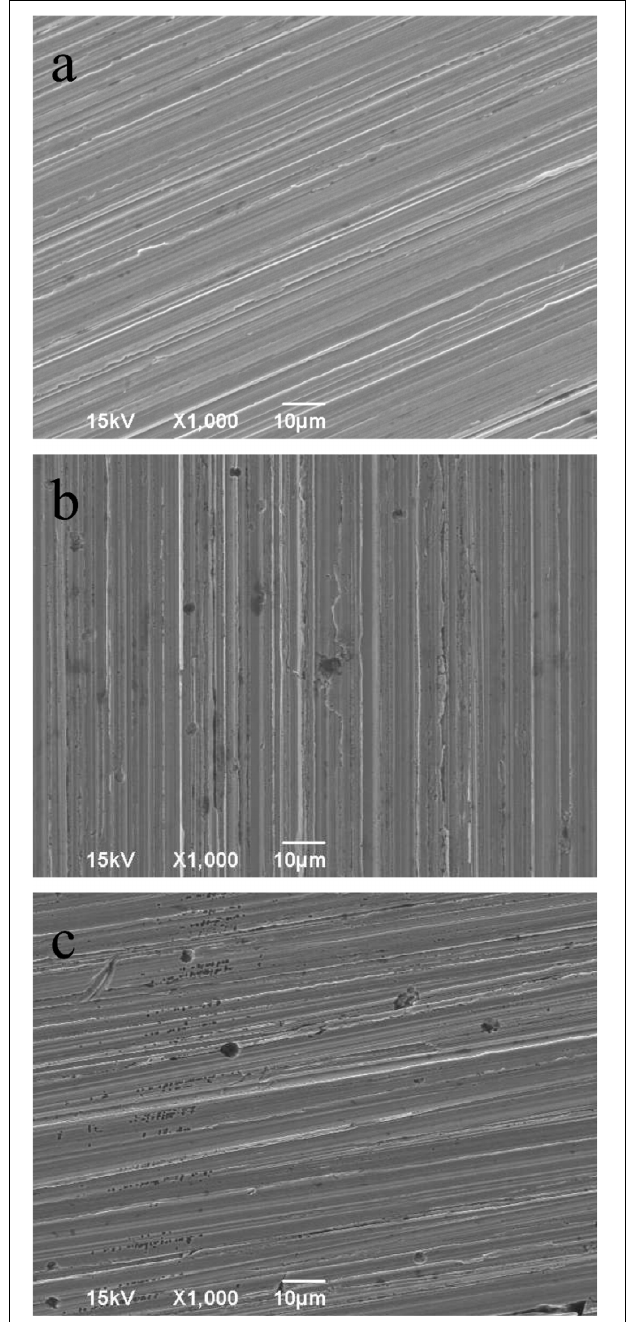
FIGURE 5 | Pit images: (a) abiotic control incubated for 14 days, (b) inoculated coupon incubated for 7 days, and (c) inoculated coupon incubated for 14